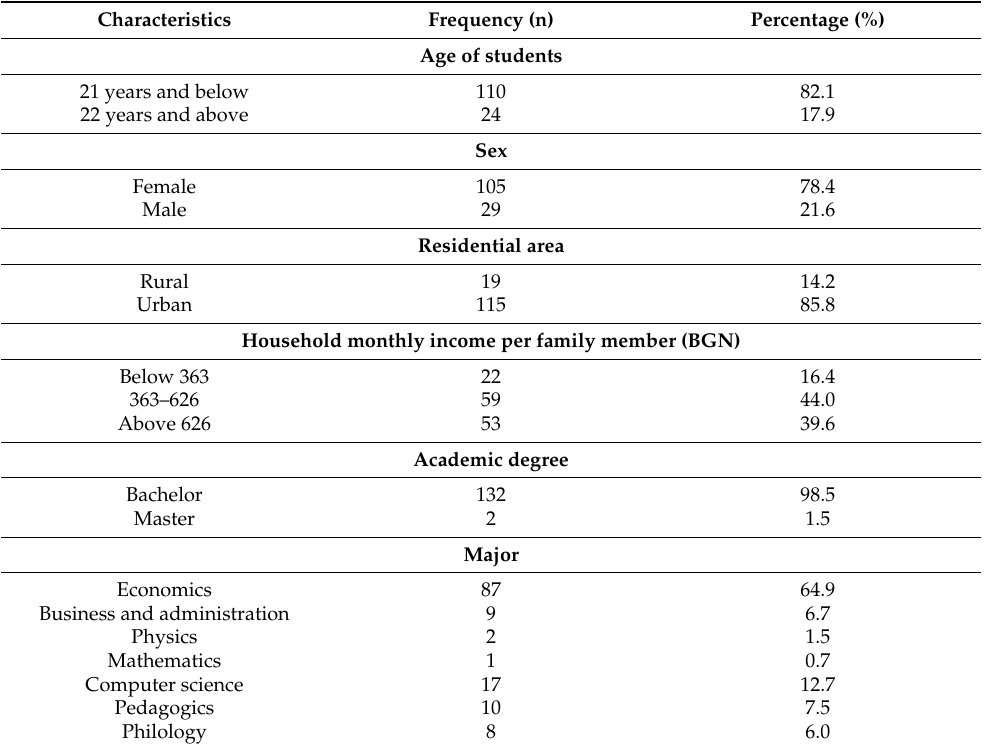
Table 2. Demographic profile of students in sample (n = 134).